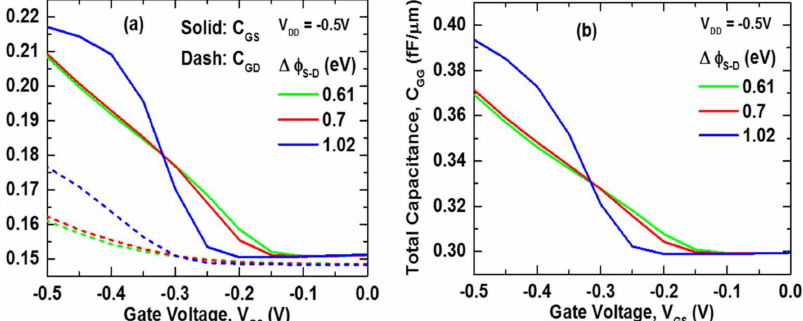
Figure 8. ( a ) Dot line: Gate-to-Drain (C GD ) and solid line: Gate-to-Source (C GS ) capacitance ( b ) total capacitance (C GG ) as a function of Gate Voltage (V GS ) at V DD = − 0.5